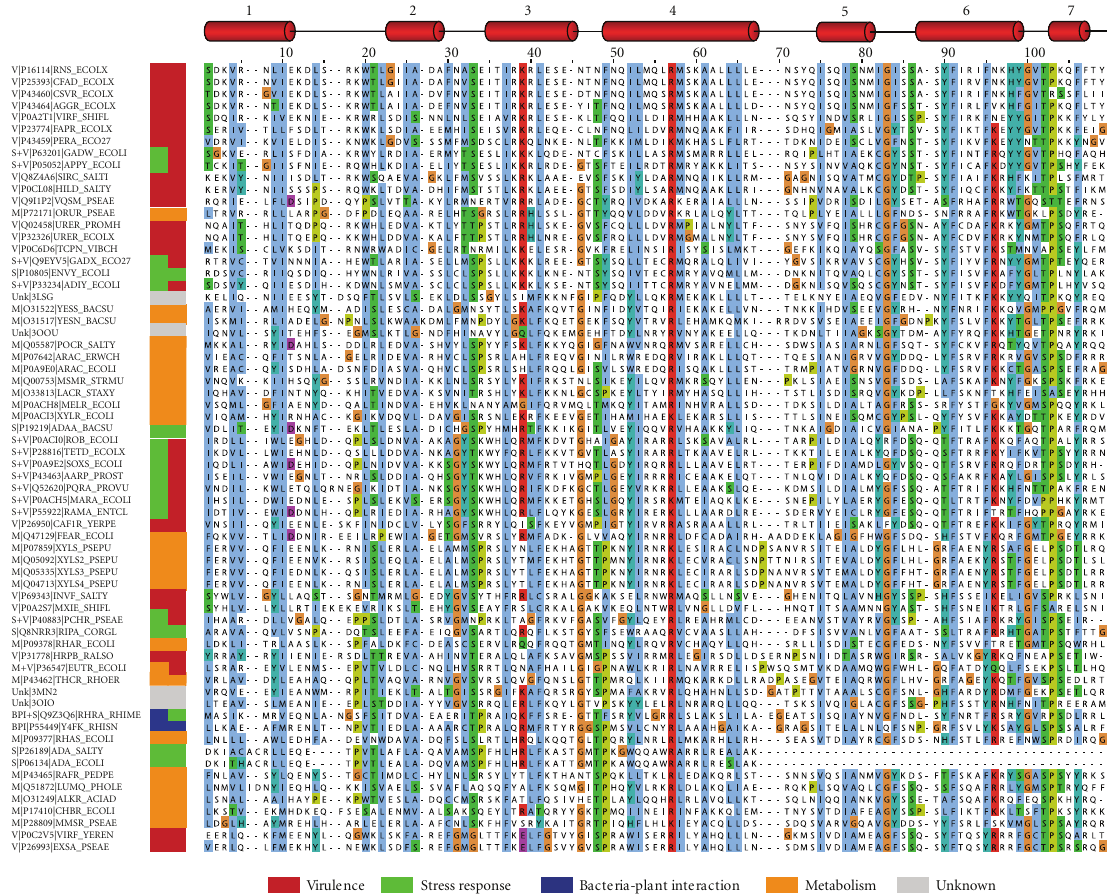
Figure 2: Multiple-sequence alignment of the DNA binding domain of 62 AraC/XylS family members with experimental evidence of their biological role. Four proteins found by the structural similarity search and whose function is unknown or poorly characterized were included in this multiple sequence alignment. Each sequence label contains the general functional category, the UniProt accession code, and the protein name. Functional categories are BPI: bacteria-plant interaction; M: metabolism; S: stress response; V: virulence and Unk: unknown. One or two functional categories were assigned. The sequences are sorted according to the tree order (see Figure 3). Secondary structure elements are given at the top (according to MarA (PDB code: 1bl0)). The alignment was plotted with JalView version 2.6.1 [24]. Color legend: light blue: hydrophobic; green: polar and aliphatic; turquois: polar and aromatic; red: basic; purple: acidic; orange: glycine; yellow: